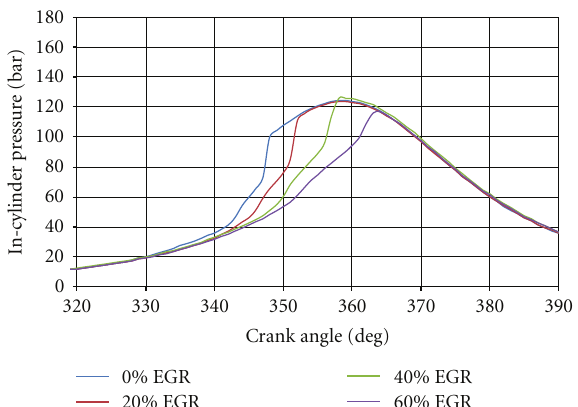
Figure 18: E ff ect of EGR on in-cylinder pressure (1400rpm; 25% load; 17.5 CR).